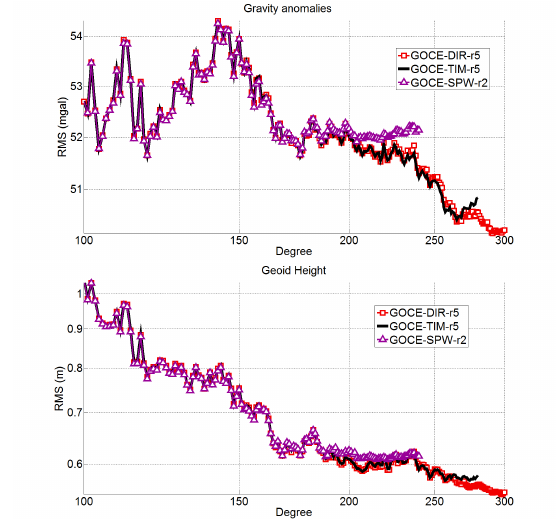
Figure 4: RMS variations in geoid undulation that have been ob- tained from comparison between terrestrial GPS/levelling data and computed values based on the EIGEN-6C3 and EGM2008 models. RMS differences (EIGEN-6C3 minus EGM2008) at the level of few mm are captured over the degree 1000 while wide discrepancies are occurred in the degree bandwidth 70 to 250.